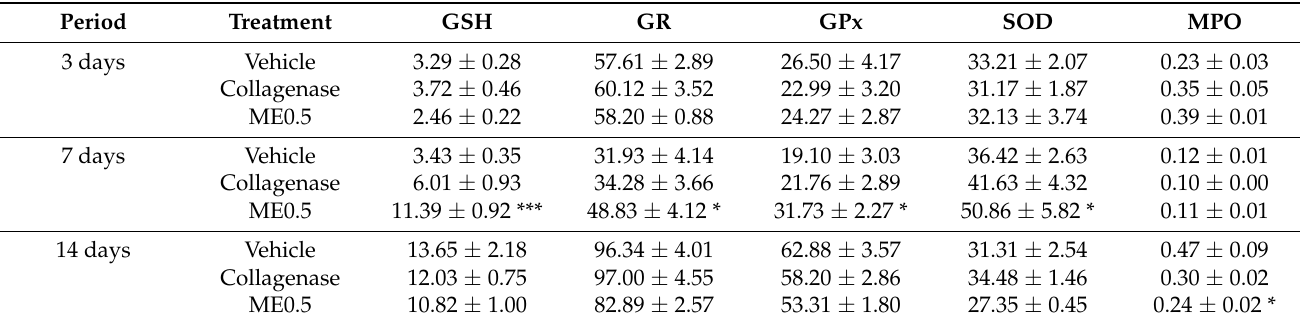
Table 2. Quantity of GSH and activities of GR, GPx, SOD, and MPO after 3, 7 or 14 days of wound treatment with vehicle, collagenase cream or ME0.5.